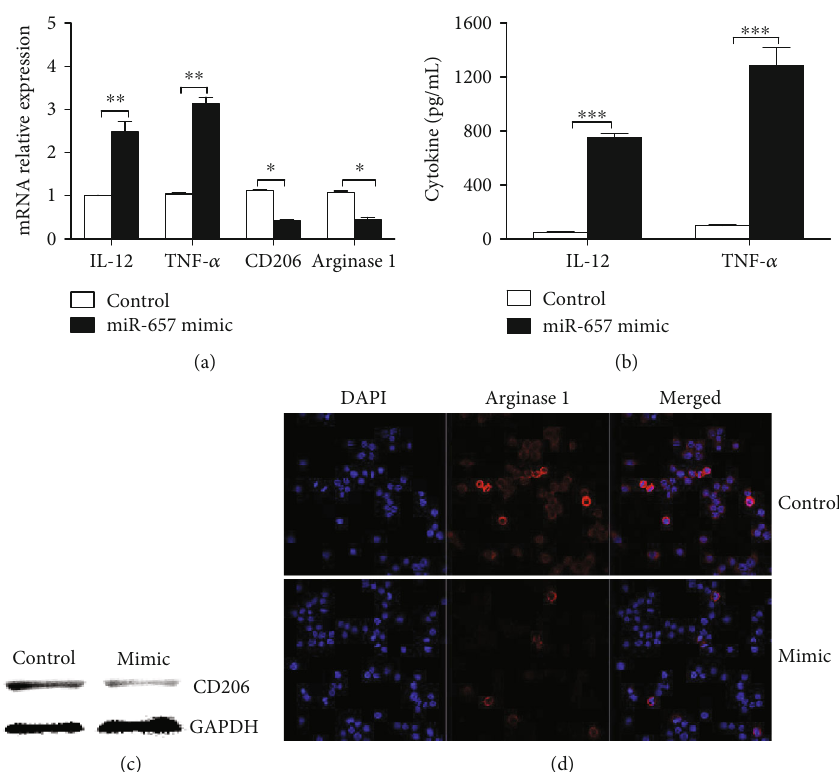
Figure 2: miR-657 is associated with the polarization of macrophages in GDM. (a) mRNA expression of IL-12, TNF- α , CD206, and Arginase 1 in miR-657 mimics treated macrophages ( ∗ P < 0 : 05 ; ∗∗ P < 0 : 01 ; representative data of three independent experiments). (b) Expression of IL-12 and TNF- α in the supernatant of miR-657 mimics treated THP-1 cells ( ∗∗∗ P < 0 : 001 ; data of three repeated experiments). (c) Expression of CD206 protein in THP-1 cells determined by western blot (representative picture of three independent tests). (d) Arginase 1 is decreased in miR-657 mimics treated THP-1 cells as evidenced by immuno fl uorescence (representative picture of three independent